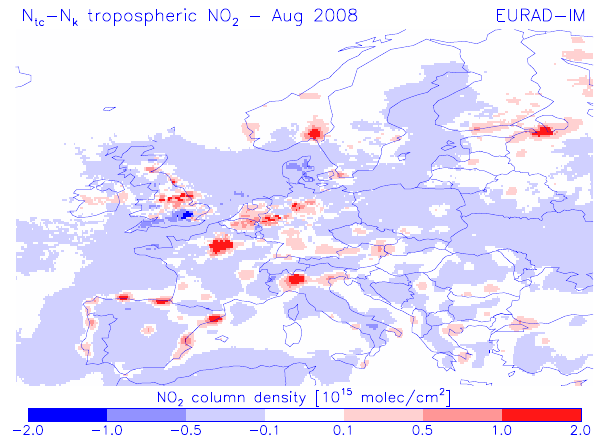
Fig. 13. Monthly mean difference between the direct modeled columns ( N tc ) and the modeled columns where the averaging ker- nels are applied ( N k ) for EURAD-IM in August